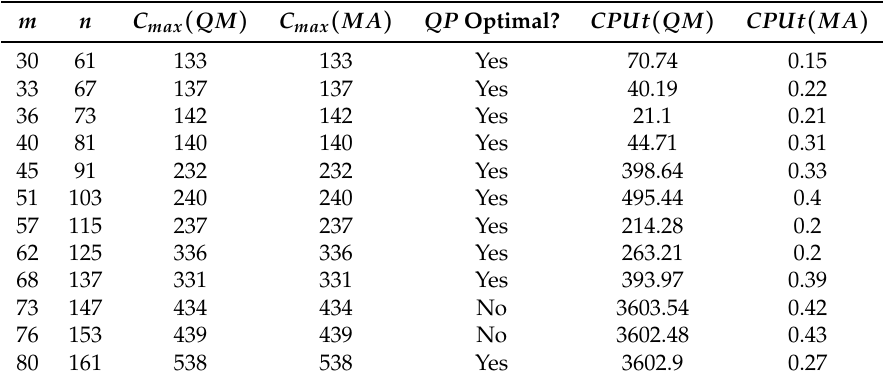
Table 7. Comparison of QM and MA for datasets DS 2.